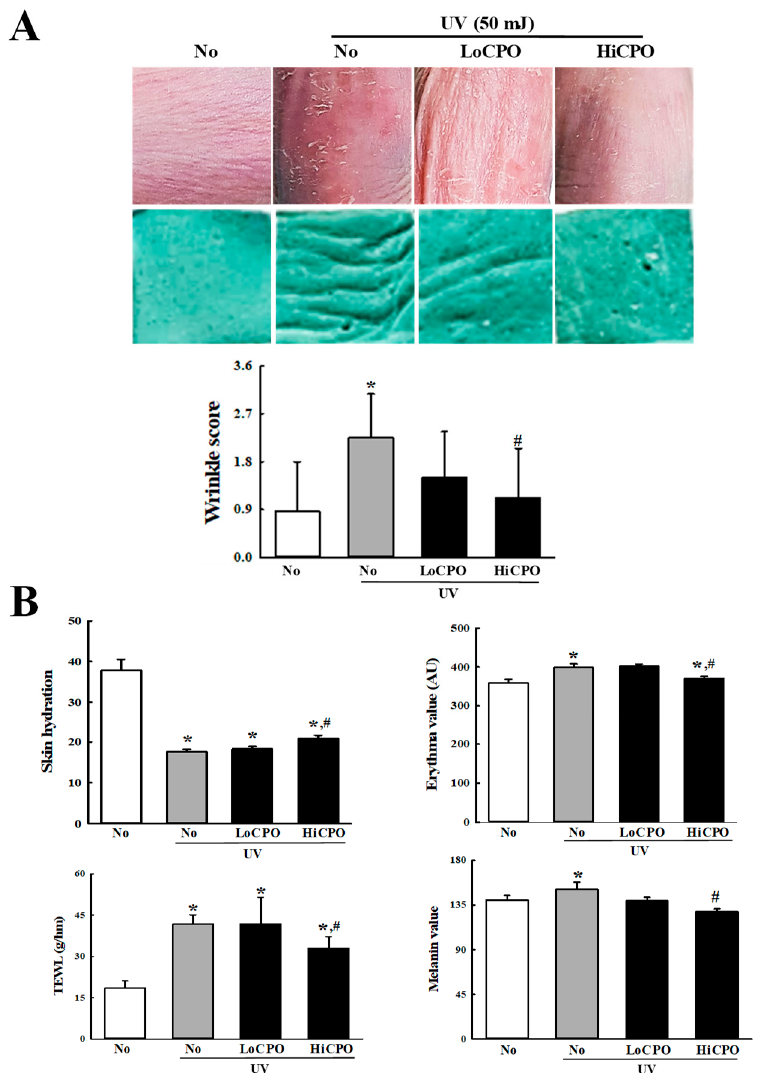
Figure 7. Skin phenotypical analyses of UV + CPO treated mice. ( A ) Wrinkle formation on the skin was measured by replica grading after 4 weeks of CPO treatment. Wrinkles were assessed as described by Bissett et al. [19] (grade 0, no wrinkles; grade 1, a few shallow wrinkles; grade 2, some wrinkles; grade 3, several deep wrinkles). ( B ) TEWL, skin hydration, and erythema and melanin indices of dorsal skins were analyzed in triplicate as described in Materials and Methods. Three to five mice per group were used and two di ff erent dorsal skin areas per mouse were assayed in duplicate. Data are reported as the means ± SD. * p < 0.05 compared to the No group. # p < 0.05 compared to the UV + No group. Abbreviations: LoCPO, low amount CPO; HiCPO, high amount